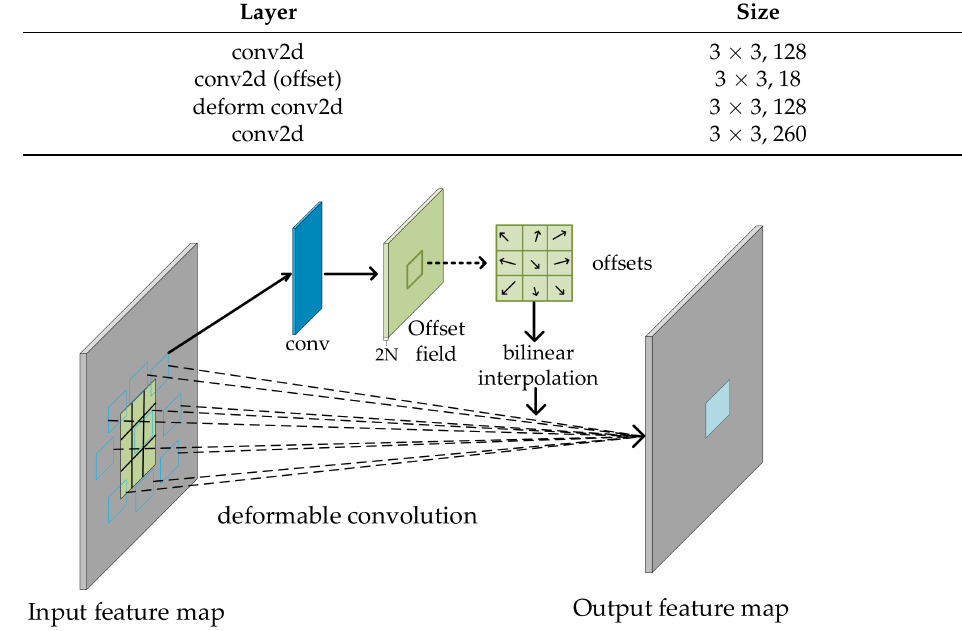
Figure 4. The implementation process for deformable